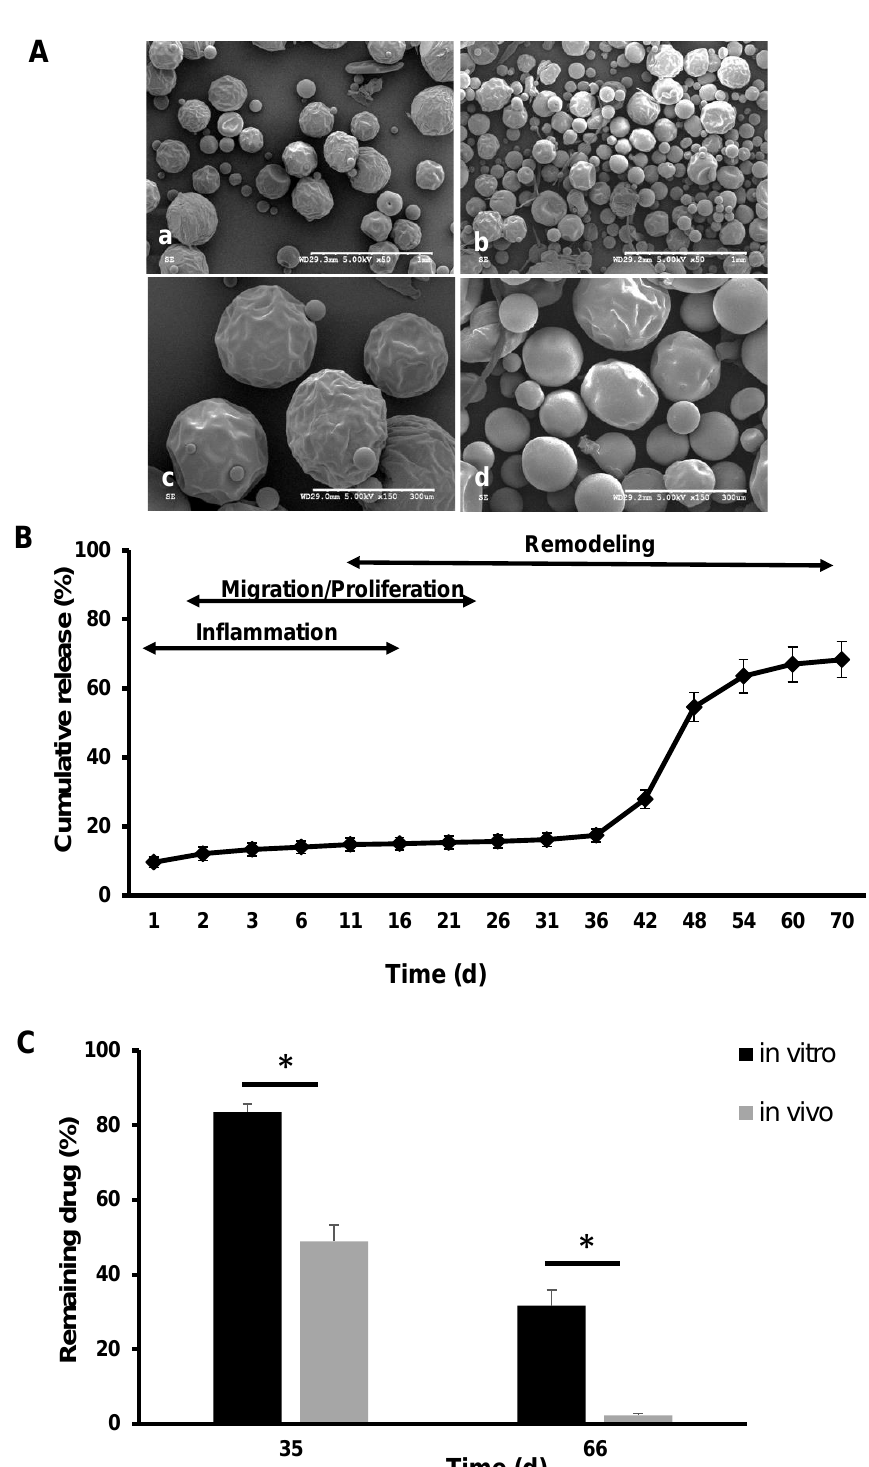
Figure 3. Scanning electron microscopy images of polymer only and KynA loaded microspheres, extended-release kinetics in vitro, and residual KynA inside microspheres in vitro and in vivo at different time points. ( A ) SEM images of empty PLGA + 17% MePEG-diblock ( a , c ) and KyA loaded PLGA + 17% MePEG-diblock microspheres ( b , d ). Scale bar: 1 mm ( a , b ), 300 µ m ( c , d ). ( B ) Extended- release profile of KynA from PLGA + 17% MePEG-diblock microspheres in vitro up to 70 days, comparative to distinct phases of wound healing (schematic illustration). ( C ) Quantitative analysis of the residual KynA in microspheres at 35 and 66 days in vivo and in vitro. Data represent the mean ± SD for n = 4, * statistical significance, p <